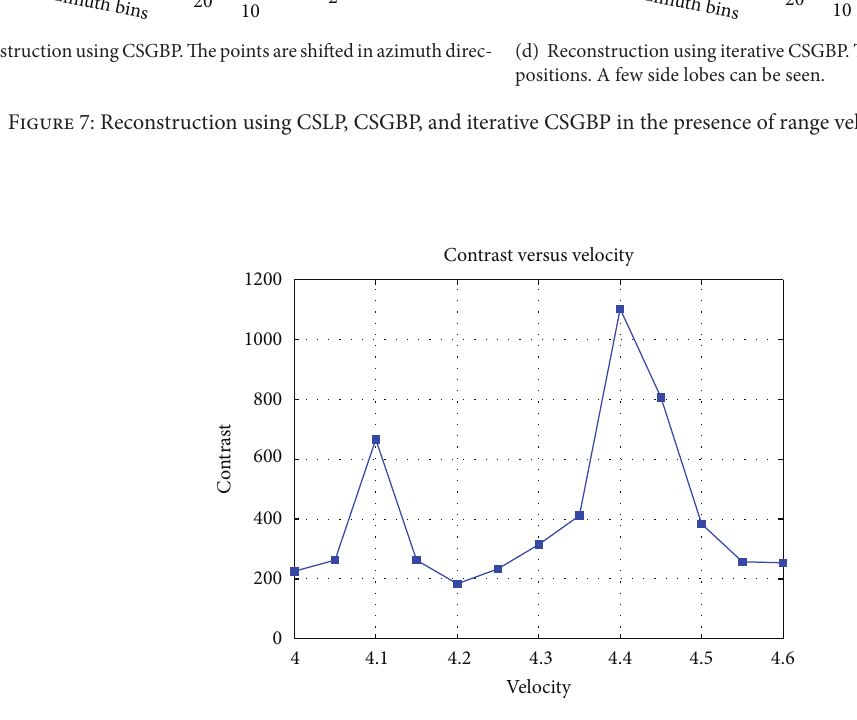
Figure 8: Contrast versus velocity. The velocity of the point is 4.4